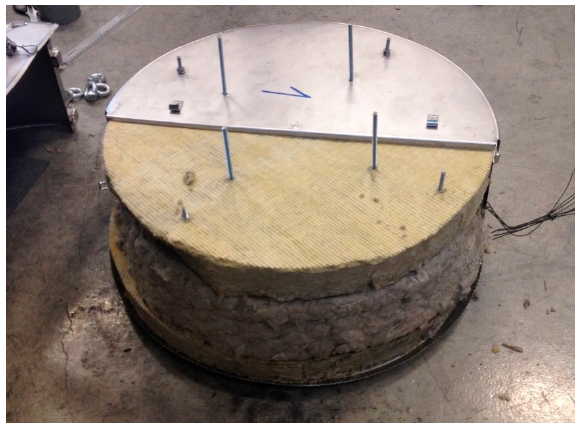
Figure 6. Mockup nearly ready for fire exposure. (Thermocouples exiting to the